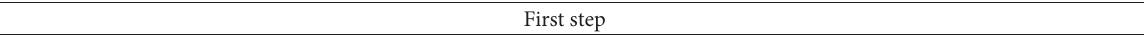
Table 1: Pulp revascularization using calcium